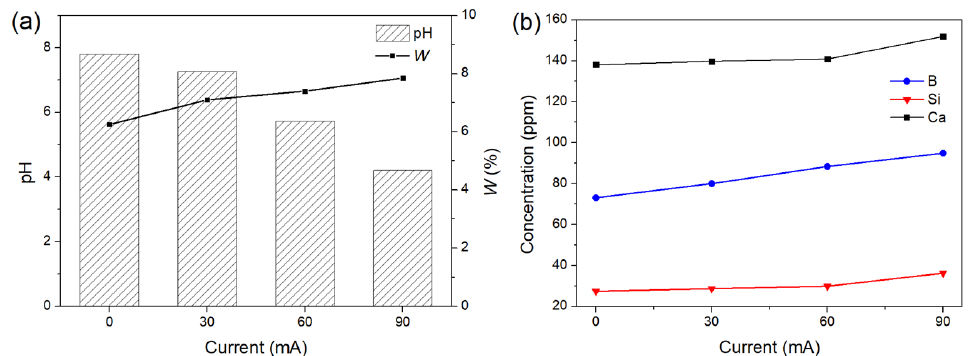
Figure 10. ( a ) The solution pH, weight loss, and ( b ) ion release after applying DC electric fields of varying current strengths for 1 h.